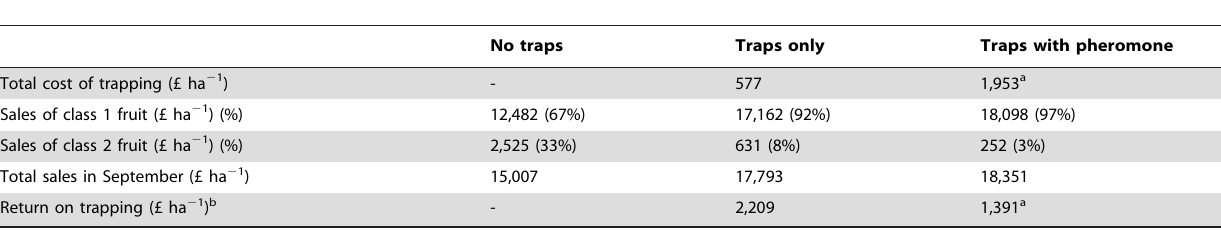
No traps Traps only